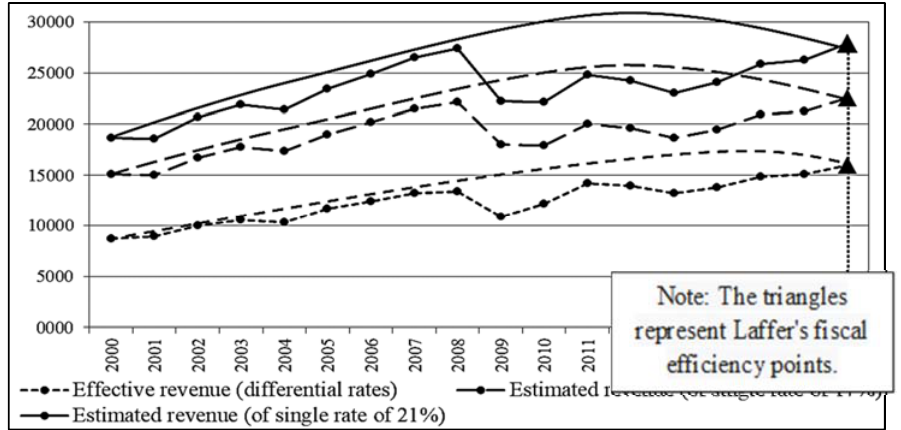
Figure 2. Laffer Curve for effective VAT revenue with differentiated rates and for estimated VAT revenues with single rates of 17% and 21% (in M€). Source: Own elaboration